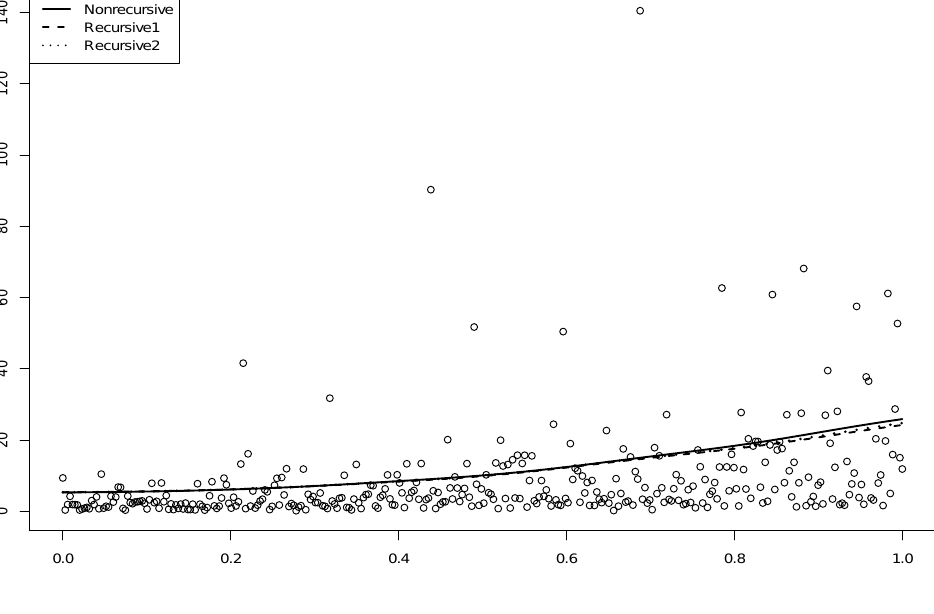
Figure 1: Qualitative comparison between three kernel relative regression estimators; non-recursive correspond to the es- timator (5) using the proposed plug-in bandwidth selection (17), Recursive 1 correspond to the estimator (4) using the pro- posed plug-in bandwidth selection (14) and the stepsize ( γ n ) = (cid:0) n −1 (cid:1) , Recursive 2 correspond to the estimator (4) using the proposed plug-in bandwidth selection (14) and the stepsize ( γ n ) = (cid:0) h n / (cid:2)(cid:80) n X ∼ U (0, 1) and ε ∼ N (0, 1)